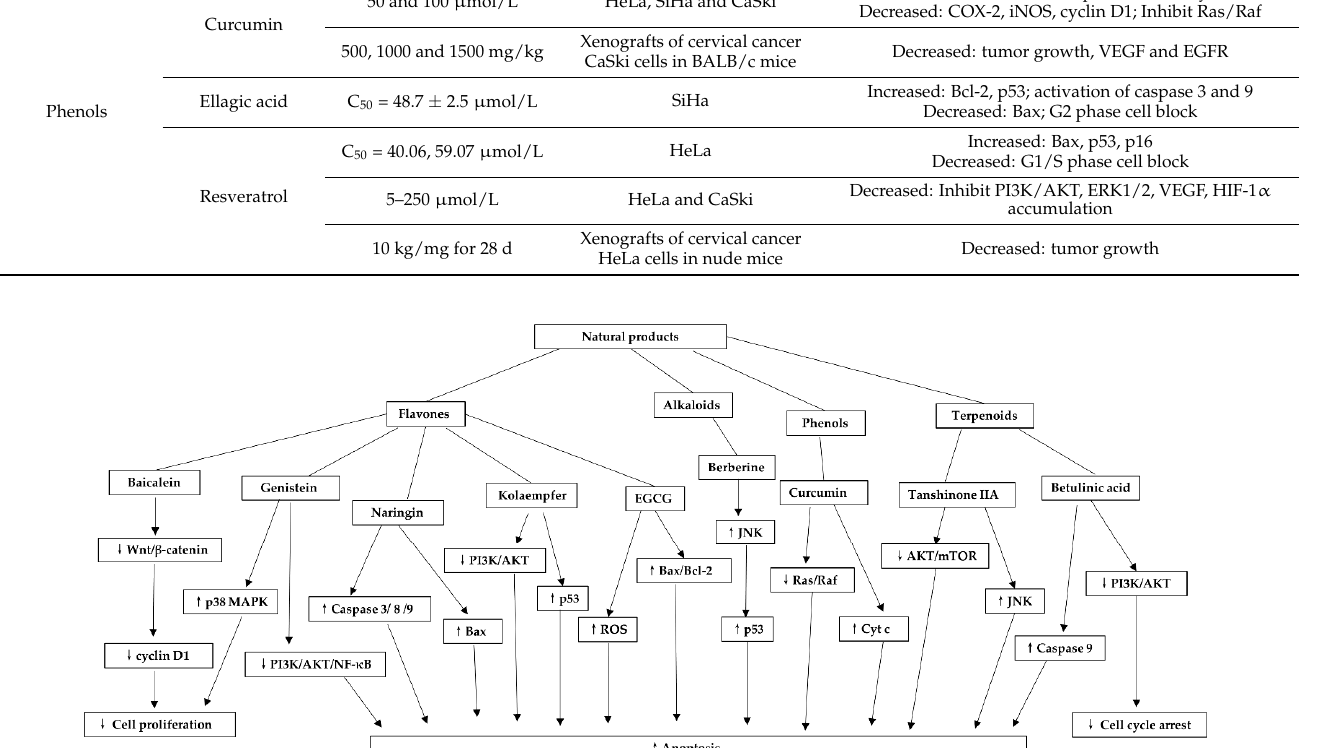
Figure 5. Mechanism of natural products against cervical cancer. Baicalein inhibits Cyclin D1 expression through